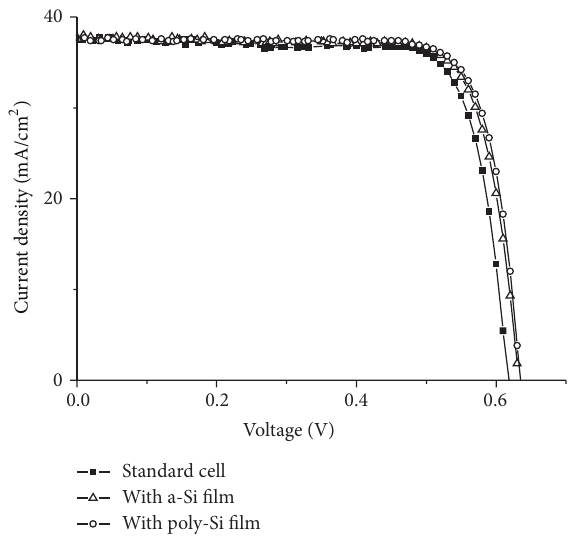
Figure 9: I - V plots of a standard cell ( ◼ ), a cell with poly-Si film ( I ), and a cell with a-Si film ( Δ ) obtained under the standard test